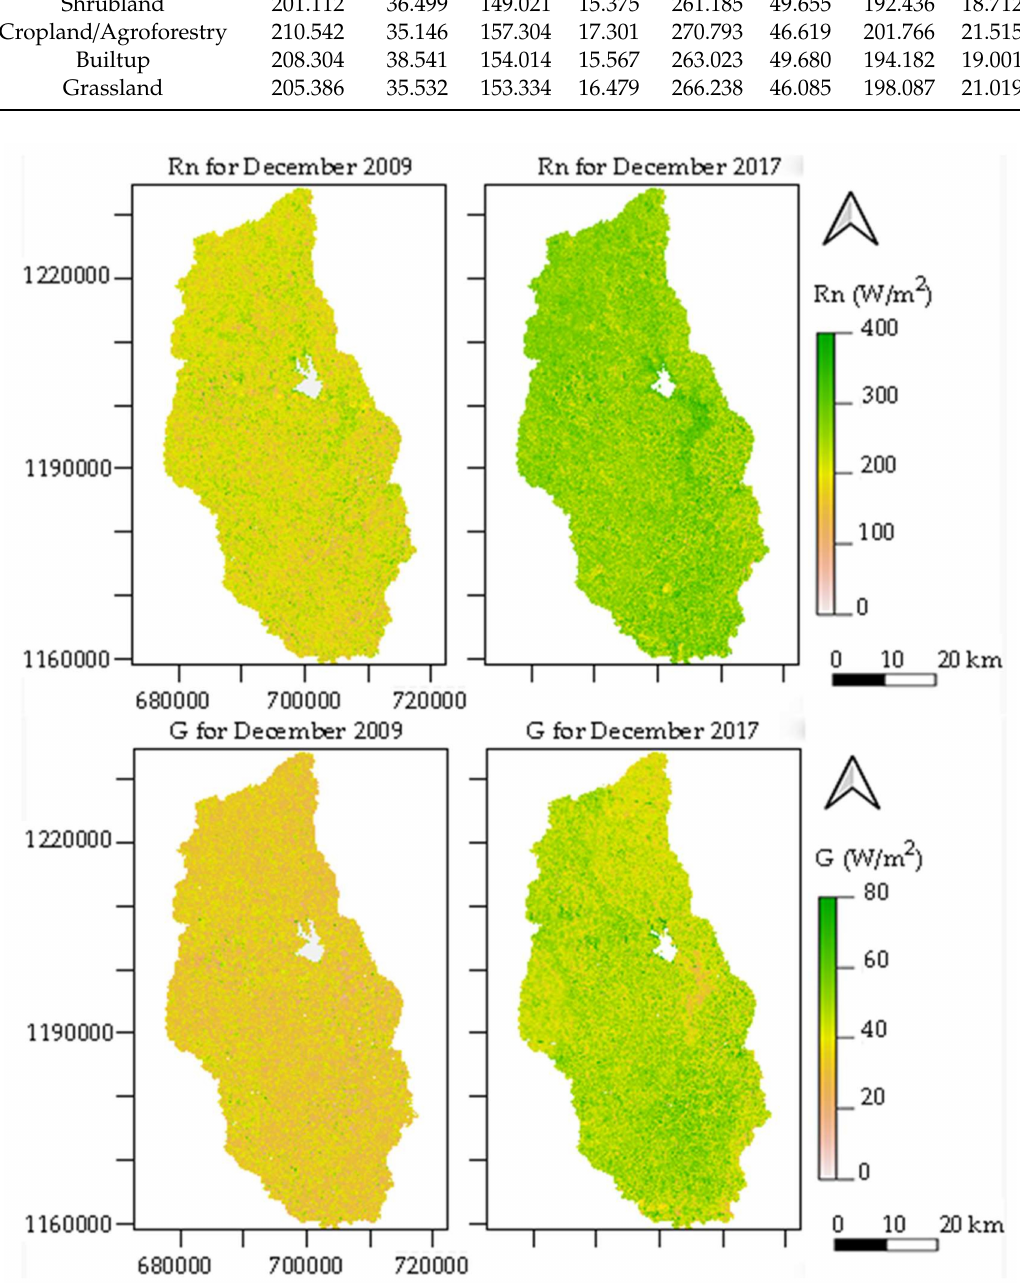
Figure 10. Net radiation (Rn) and soil heat flux (G) for December 2017 and